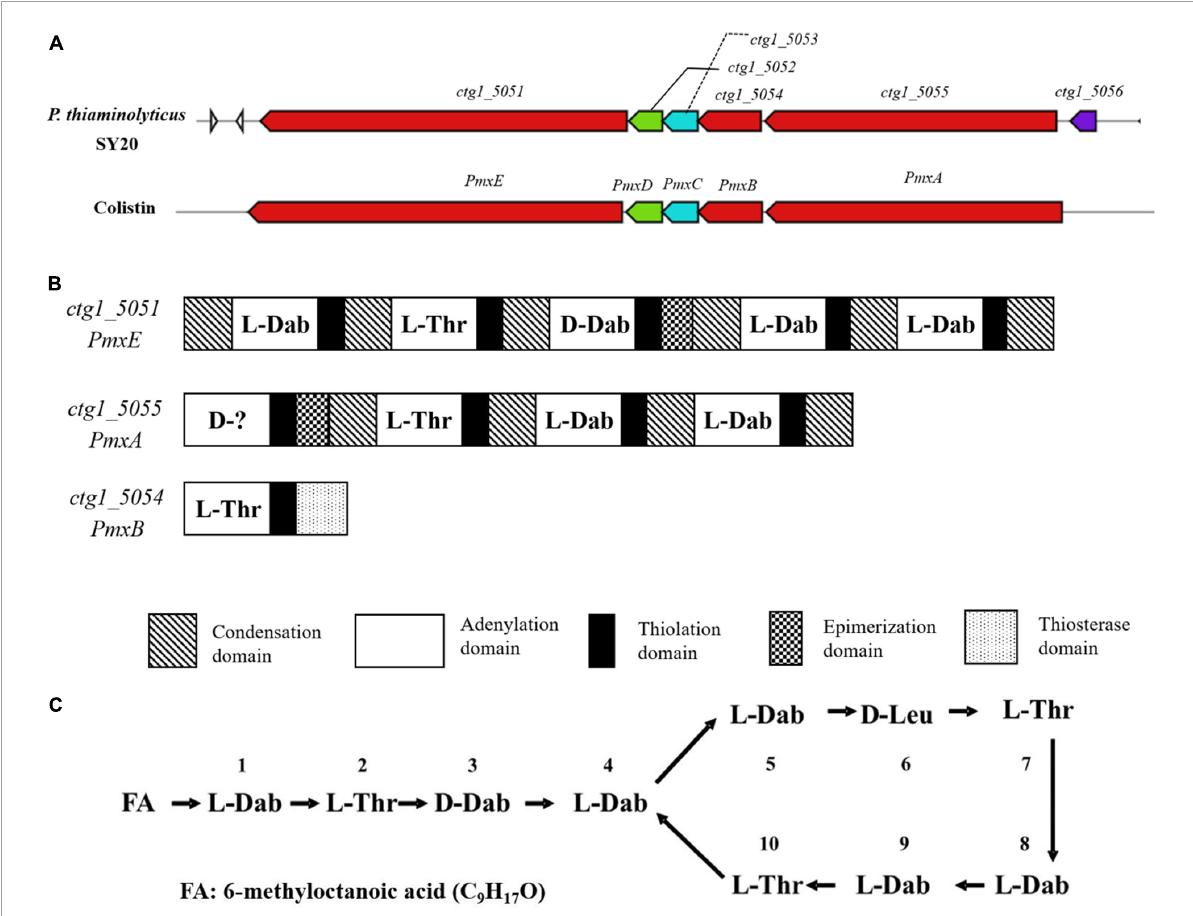
FIGURE6 Analysis of NRPS gene cluster and the structure of polymyxin A1 from P. thiaminolyticus SY20. (A) The pmx gene cluster of colistin and a hybrid NRPS gene cluster in P. thiaminolyticus SY20; (B) genetic structure of the hybrid NRPS gene cluster and domain organization of every modular; (C) Primary structure of polymyxin A1, FA: 6-methyloctanoic